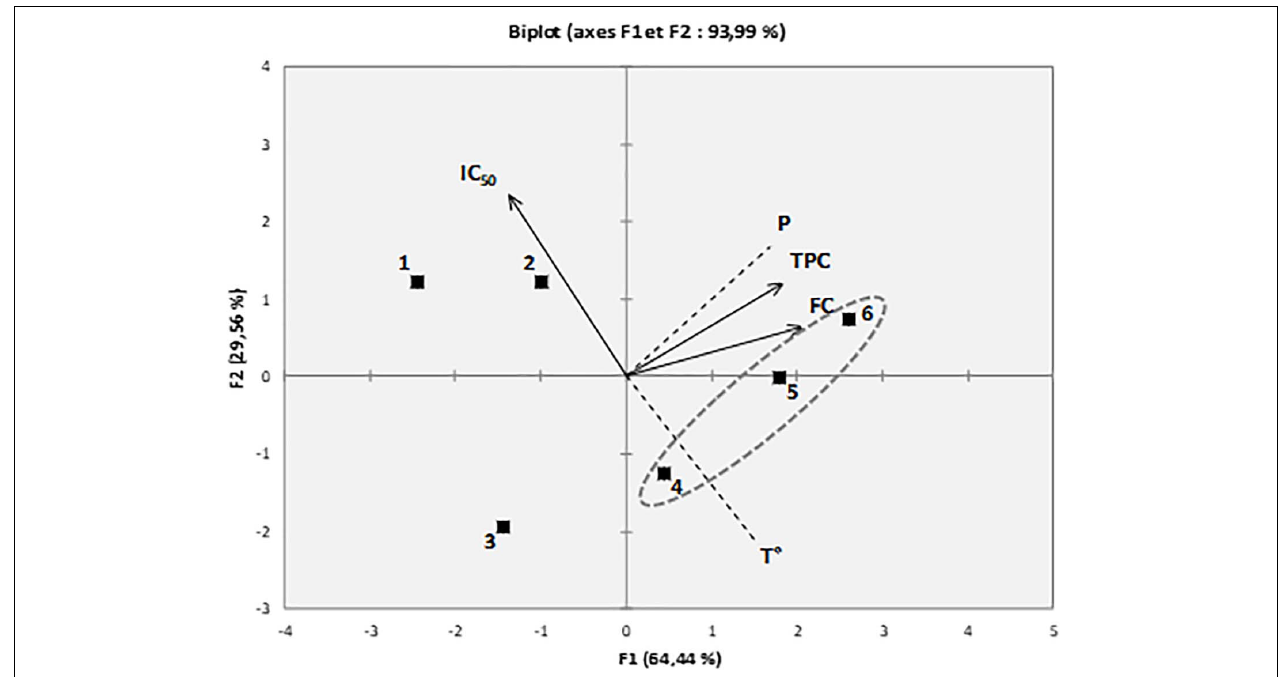
FIGURE 5 | Principal component analysis (PCA) of fucoxanthin content (FC), total phenolic content (TPC), DPPH radical-scavenging capacity (IC 50 ), and ScCO 2 parameters [temperature (T) and pressure (P)] of D. polypodioides extracts.